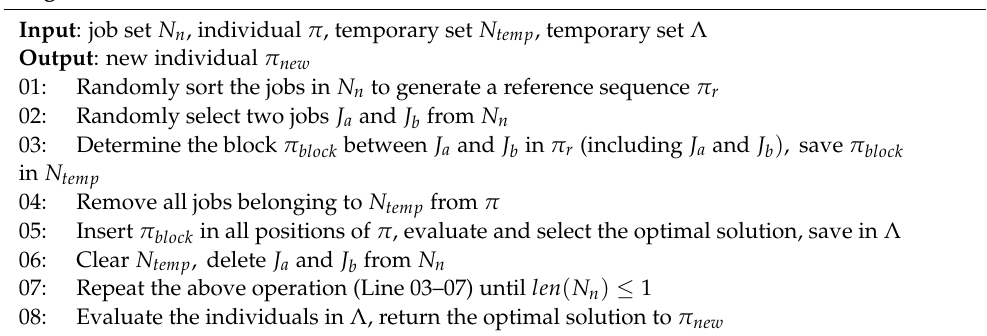
Algorithm 4 BRRLS